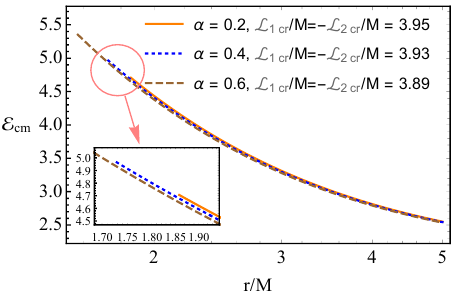
Figure 14. Radial profiles of center of mass energy of the collisions of two neutral particles with neutral particles for different values of the GB parameter and corresponding critic angular momentum.